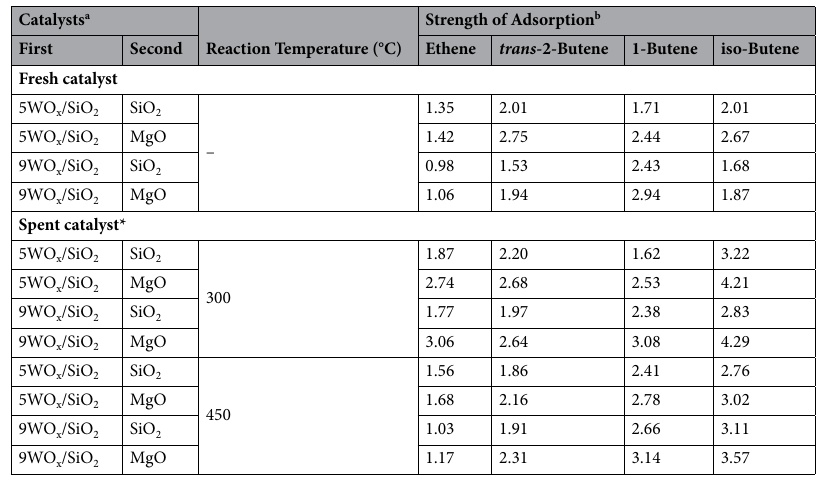
Table 3. Strenght of adsorption with the various probe molecules that adsorbed on the WO x /SiO 2 + SiO 2 and WO x /SiO 2 + MgO catalysts. Compared between fresh and spent catalysts with different of reaction temperature. a First and second catalysts were mixed by physically process. b Strenght of adsorption; Ratios of adsorption energy (J·g catalyst −1 ) from in situ DSC measurements and DRIFTS Area (a.u. ·g catalyst −1 ) (area integrated at wavenumber 1660–1720 cm −1 ; isolated C = C and C = C conjugated with aryl) from in situ DRIFTS measurements. *Spent catalysts; 8 h of time on stream (TOS).